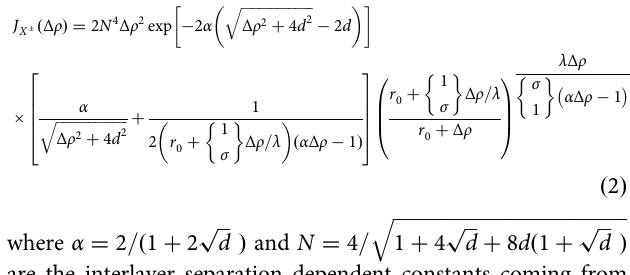
are the interlayer separation dependent constants coming from the indirect (interlayer) exciton wave function 37 , and the upper or lower term should be taken in the curly brackets for the positive